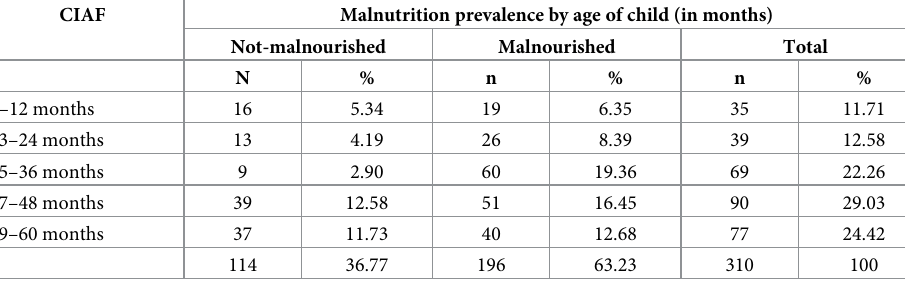
Table 3. Malnutrition prevalence by age of the child (in months).